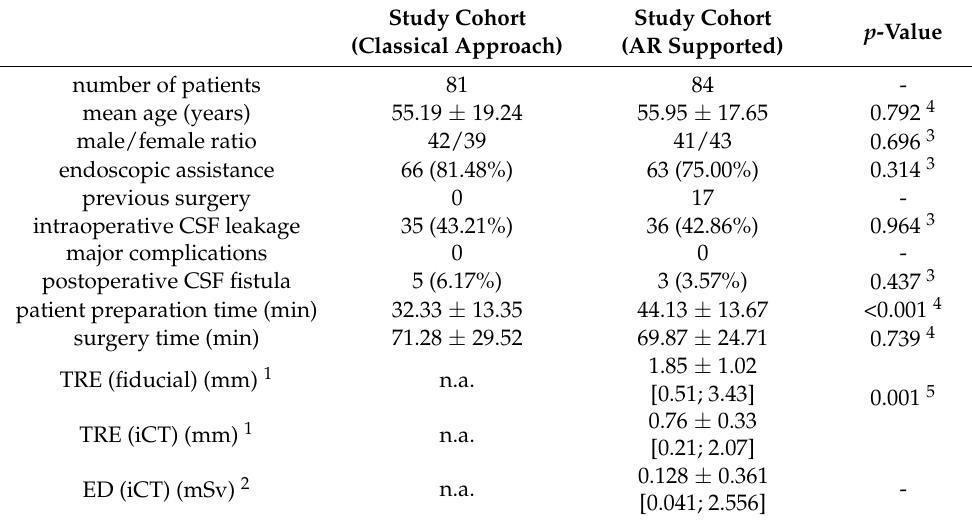
Table 1. Summary of